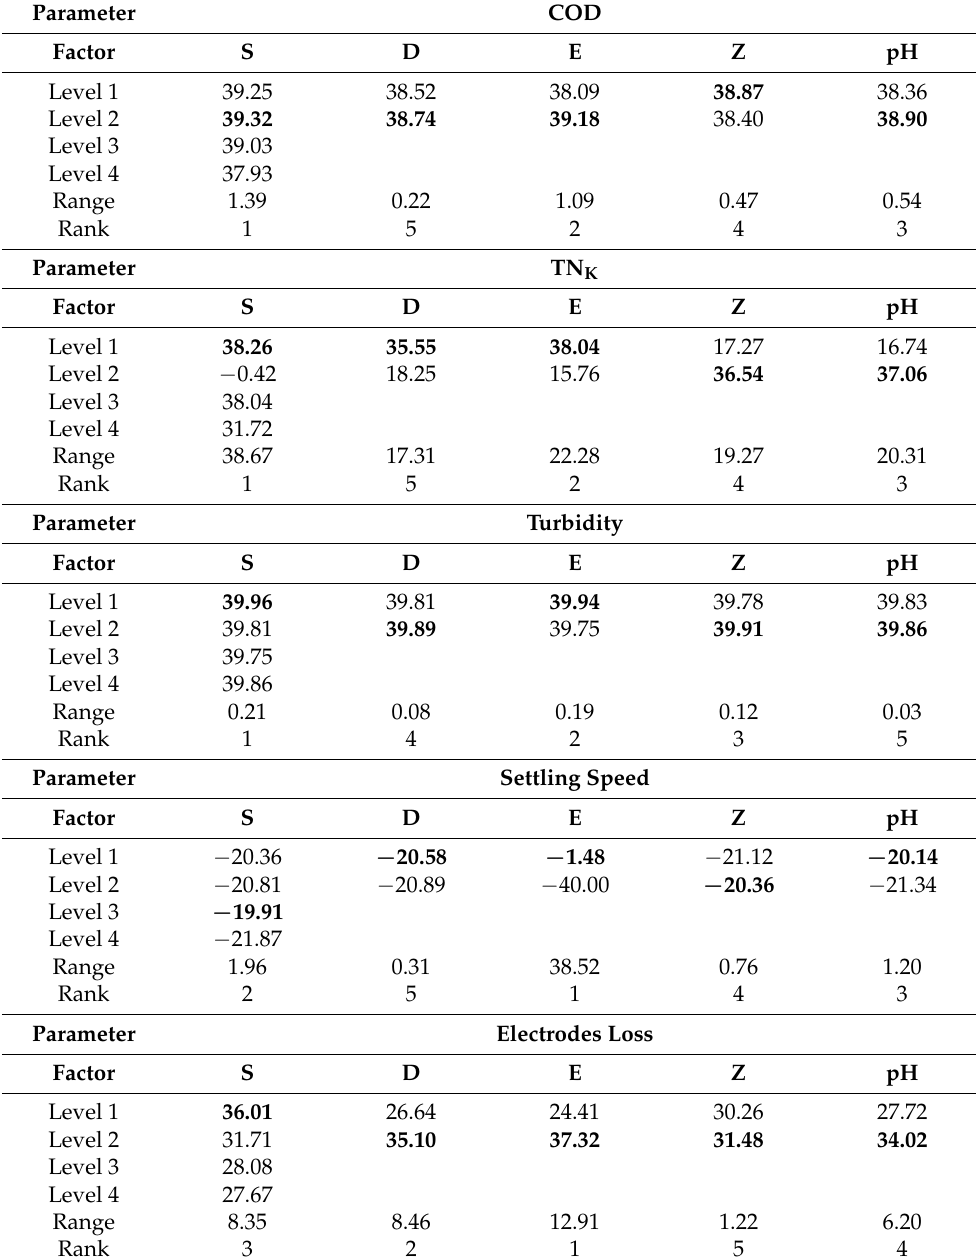
Table 9. S/N FL values and factors rank for COD, TN K , turbidity, settling speed, and electrodes loss. The bold values represents optimal